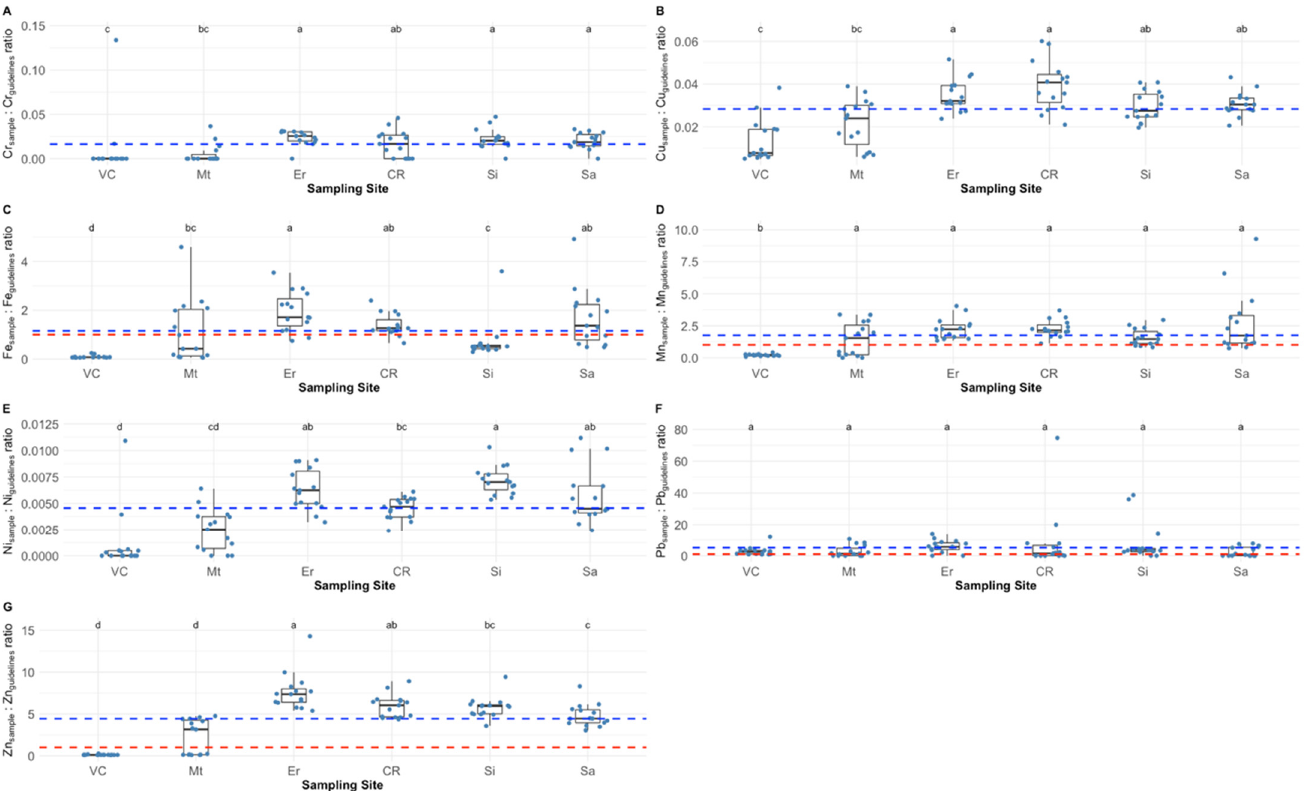
Figure 2. Chromium, ( A ), copper ( B ), iron ( C ), manganese ( D ), nickel ( E ), lead ( F ) and zinc ( G ) ratios between the measured values and the international thresholds in Pollicipes pollicipes peduncle, of the individuals collected at the six sampling sites (VC—Viana do Castelo; Mt—Matosinhos; Er—Ericeira; CR—Cabo Raso; Si—Sines; Sa—Sagres; dotted blue lines represent the average value detected for the whole dataset; the dotted red line represents the safety threshold ratio (ratio = 1) according to international regulatory authorities; for Cr, Cu and Ni the international threshold guidelines are far above the results attained from this study samples and thus the correspondent dotted red lines were are not displayed). Statistical letters denote significant differences between sampling sites at p < 0.05.